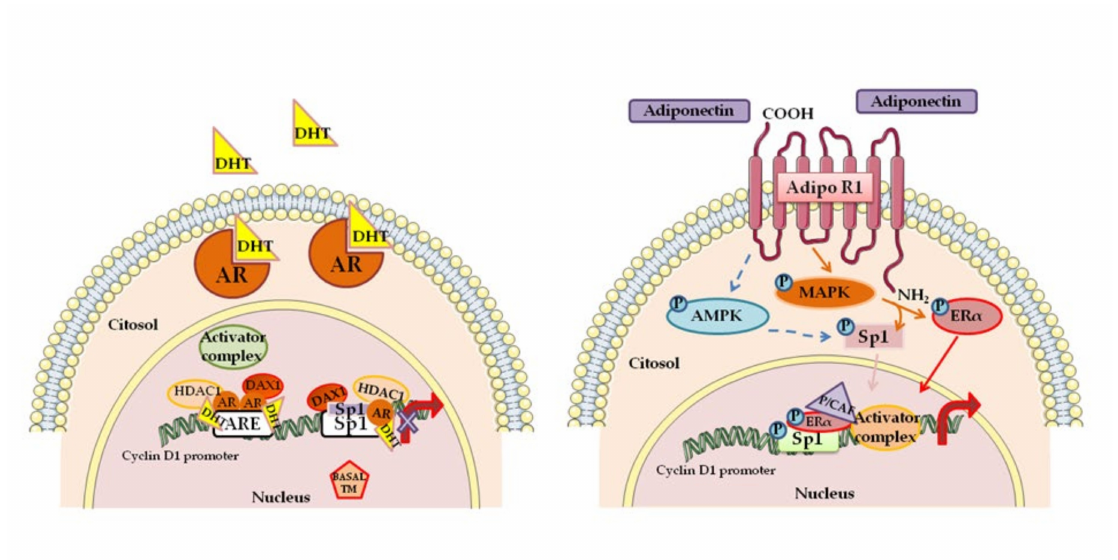
Figure 1. A schematic summary illustrating mechanisms targeting Cyclin D1 in estrogen receptor α (Er α )-positive breast cancer cells. LEFT PANEL Cyclin D1 as a key target of dihydrotestosterone (DHT) / androgen receptor (AR) action in breast cancer cells for the repression of cell proliferation [54]. RIGHT PANEL. Cyclin D1 as a key target of adiponectin action in ER α - positive breast cancer cells. Adiponectin induced signals, AMP-activated protein kinase (AMPK) and mitogen-activated protein kinase (MAPK), phosphorylate both specificity protein 1 (Sp1) and ER α , producing the recruitment of an activator complex on Cyclin D1 promoter. This causes the increased Cyclin D1 expression and breast tumor growth [55]. See the text for details. Abbreviations: DAX1 (corepressor complex component), ARE (androgen responsive element), histone deacetylases (HDAC1), Basal TM (basal